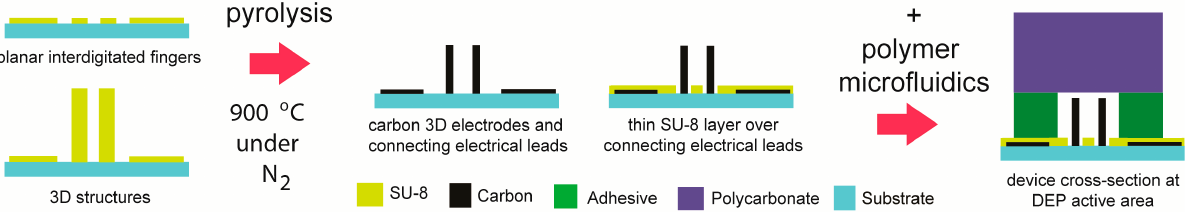
Figure 4. Fabrication sequence of microfluidics devices featuring carbon electrodes. These devices are then used to implement active filters using dielectrophoresis